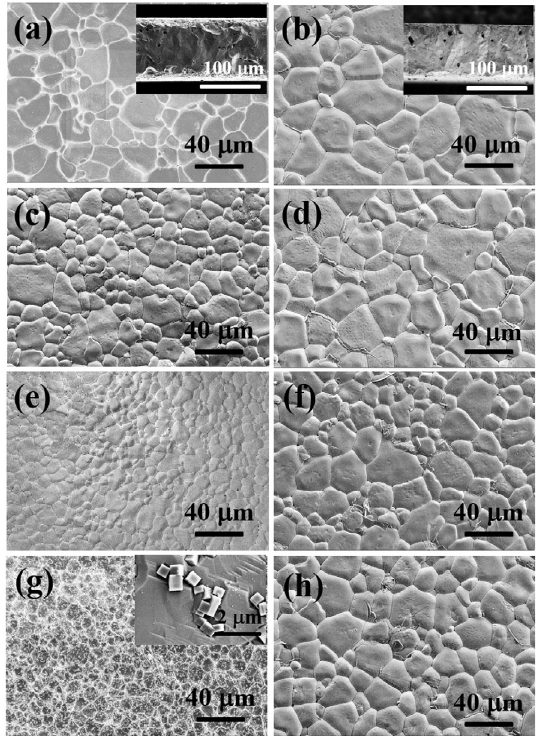
Fig. 4 SEM images of randomly oriented and textured x Er–BCTZ thick films: (a) x = 0 (R), (b) x = 0 (T), (c) x = 0.005 (R), (d) x = 0.005 (T), (e) x = 0.01 (R), (f) x = 0.01 (T), (g) x = 0.015 (R), (h) x = 0.015 (T). Insets of (a) and (b) show the corresponding cross-section images of x = 0 (R) and x = 0 (T), respectively. Inset of (g) is the partial enlarged image of x = 0.015 (R). Table 1 Relative densities and average grain sizes of randomly oriented and textured x Er–BCTZ